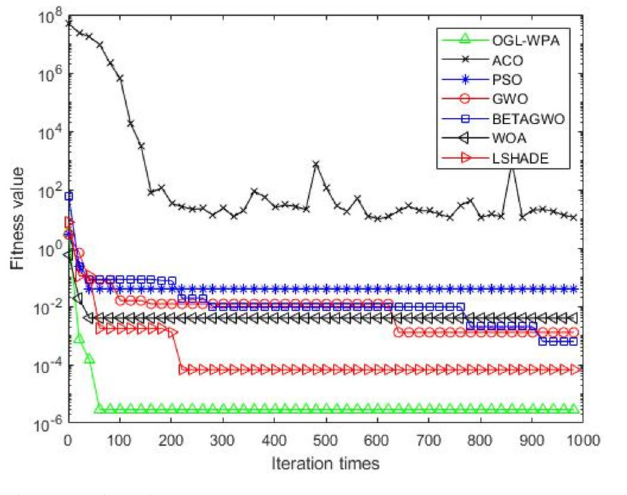
Fig 11. F10 iteration